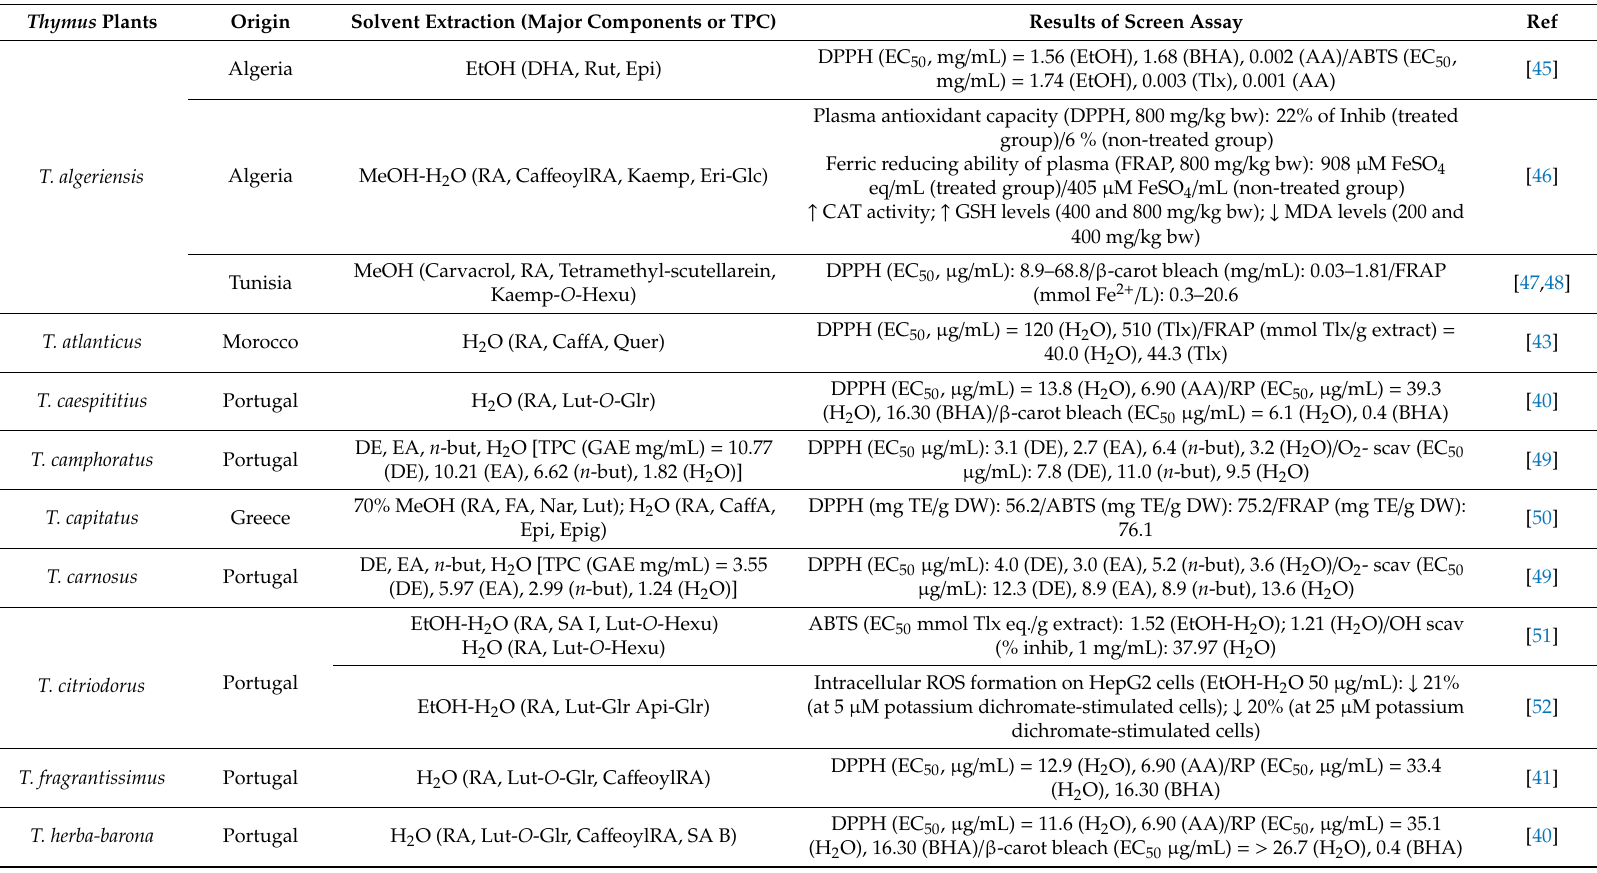
Table 1. Antioxidant properties of phenolic-rich extracts of distinct Thymus